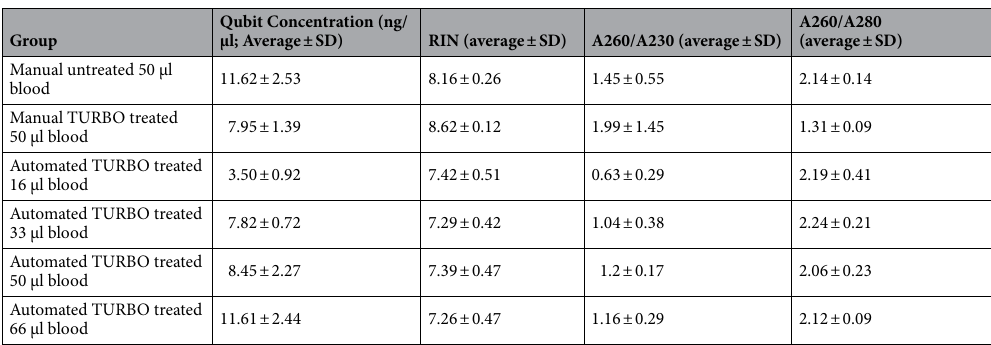
Table 1. Summary of the RNA QC metrics according to the sample groups.